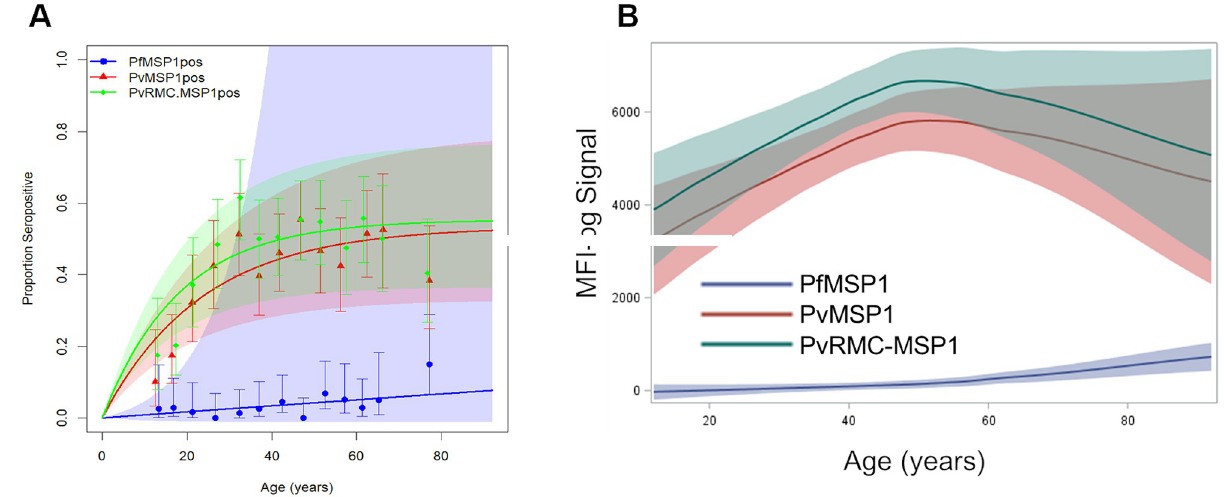
Fig 2. Population-level responses to PvRMC-MSP1, PfMSP1, and PvMSP1 from Costa Rican persons. A) Modelled seroprevalence curves for the Costa Rican study population for the three antigens, with seroconversion estimates shown in Table 2. B) LOESS regression curves for IgG assay signal of the study population to each antigen by age. The x-axis for the LOESS regression curves starts at age 12, corresponding to the youngest participant from the Costa Rican survey. A minimal anonymized data set for the responses to PvRMC-MSP1 in Costa Rica is included with the Supporting Information for this